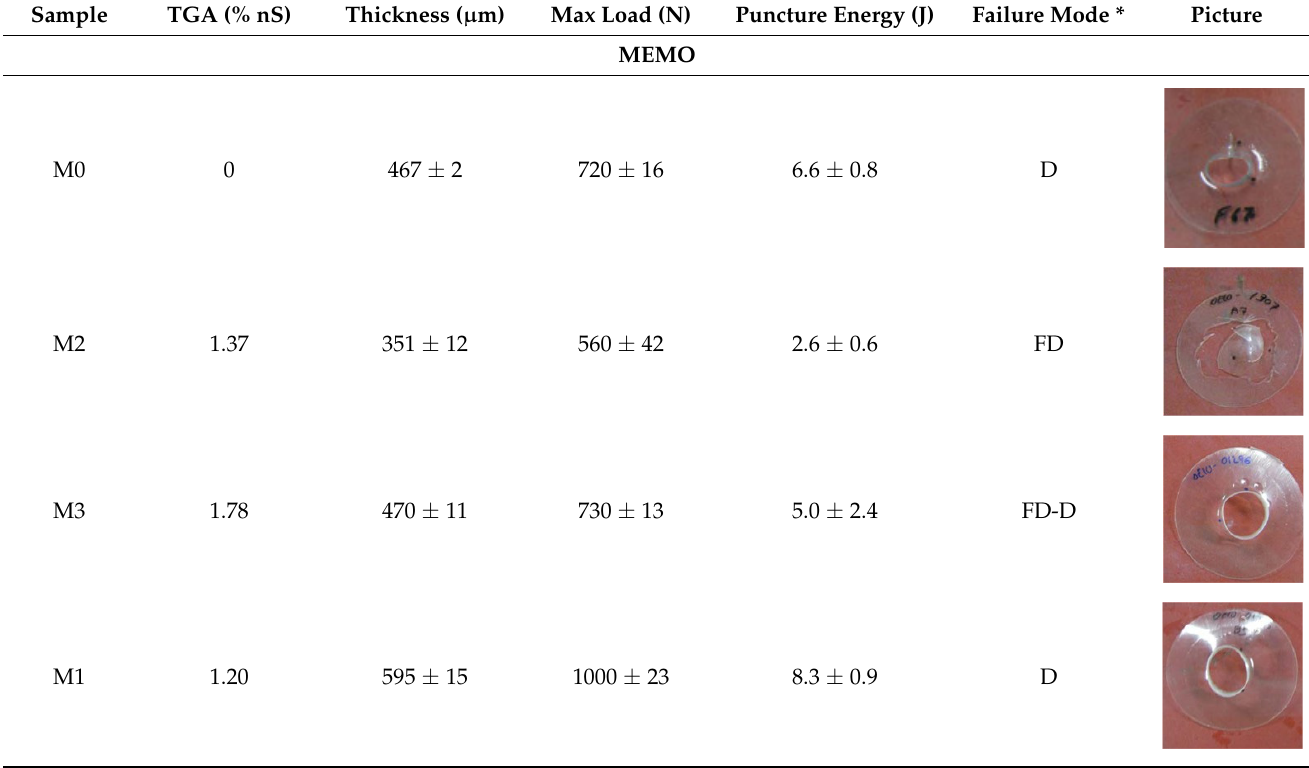
Table 2. Impact puncture results for nanocomposites containing nanosepiolite modified with MEMO (3-metracyloxypropil trimetoxysilane) and with AMEO (3-aminopropyltriethoxysilane). Sample